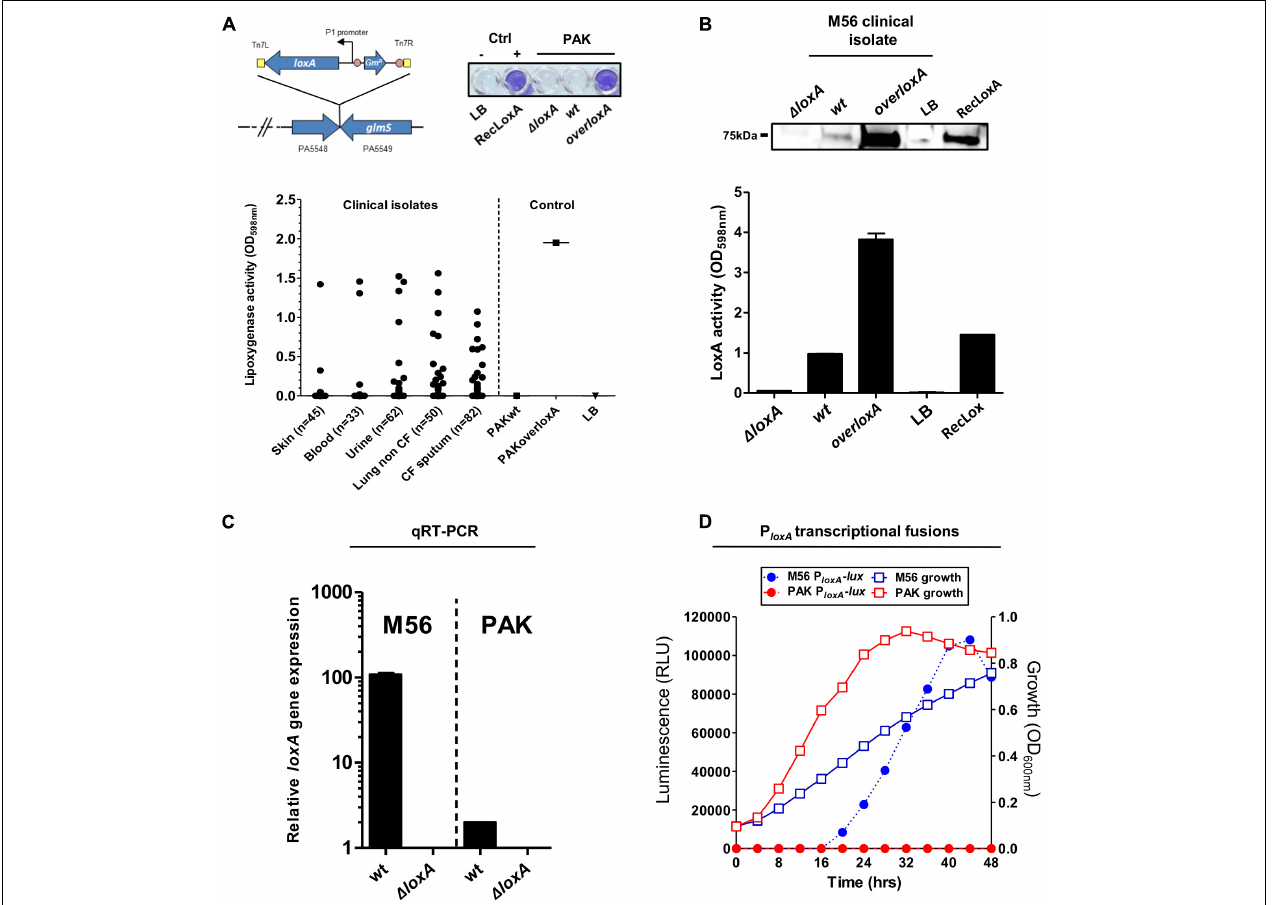
FIGURE 1 | Functional lipoxygenase LoxA is secreted by P. aeruginosa clinical isolates through loxA gene expression. (A) Colorimetric detection of lipoxygenase activity in cultures of P. aeruginosa strains. Left upper panel: schematic representation of the strategy used to construct overloxA mutants: a constitutive expression cassette of loxA gene under the control of the constitutive integron promoter P1 was inserted in the chromosomal att site (intergenic region located between genes PA5548 and PA5549 on the chromosome) using pUC18-miniTn7T vector strategy. Upper right panel: colorimetric assay performed on overnight grown cultures (50 µ l) of PAK wt , (cid:49) loxA , and overloxA mutants; recombinant LoxA (RecLoxA, 100 ng) from Pseudomonas aeruginosa strain 42A2 was included as a positive control. Lower panel: lipoxygenase activity measured in static stationary growth-phase cultures of distinct clinical isolates of P. aeruginosa . Pigmented cultures could potentially biased this colorimetric assay and have been therefore excluded from these results; PAK wt and PAK overloxA were included as a positive and negative control, respectively. (B) Lipoxygenase activity measured in culture supernatants of M56, a LoxA-positive clinical isolate. Protein extracts from static stationary phase cultures of M56 were separated by SDS-PAGE and transferred onto nitrocellulose membranes for western immunoblotting using a rabbit anti-LoxA antibody. The specific signal corresponding to LoxA protein was correlated to lipoxygenase activity, using the same culture extracts. Samples of M56 (cid:49) loxA and complemented M56 overloxA strains were used as negative and positive control, respectively. (C) Quantitative real-time PCR analysis of mRNA extracted from static stationary phase cultures of M56 wt and PAK wt . Signal measured in (cid:49) loxA mutant was considered as the background noise. (D) Dynamic LoxA promoter activity and growth of M56-P loxA - lux or PAK-P loxA - lux in liquid cultures by luminescence and absorbance measurements, respectively. Colonies isolated from fresh LB-agar plates were inoculated into 4 mL of LB medium (initial OD 600 nm 0.1) into 6-well plates. Optical densities and luminescence emission were monitored during 48 h at 28 ◦ C under static conditions, using a Tecan M200